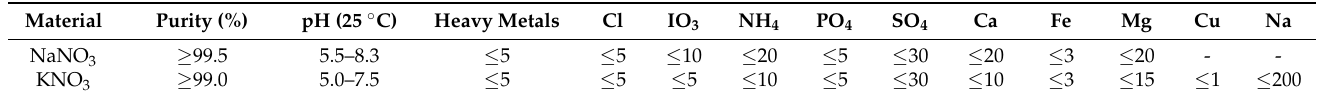
Table 2. Salt specifications (parts per million (ppm), unless otherwise stated).